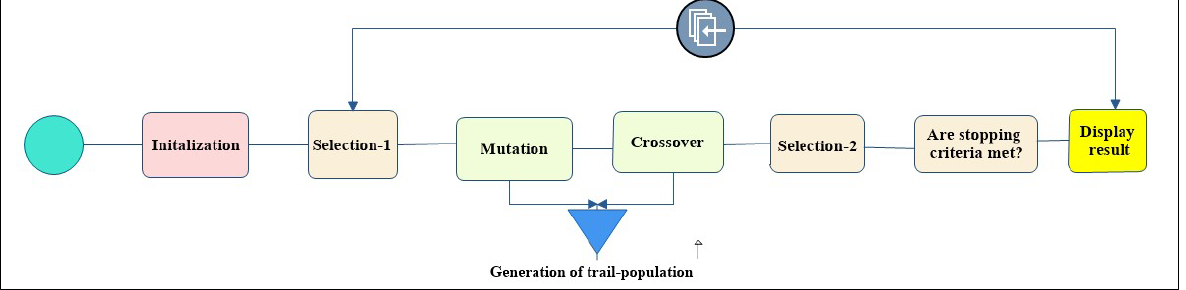
Figure 4. General flow chart of BSA.